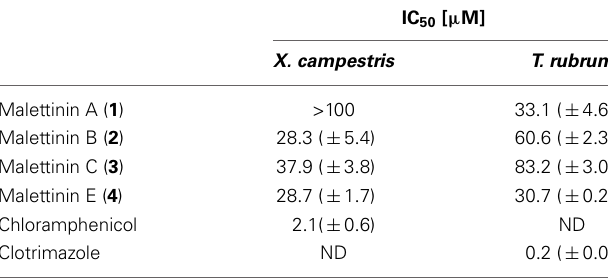
FIGURE 2 | Selected HMBC (arrows) and COSY (bold) correlations for 4.